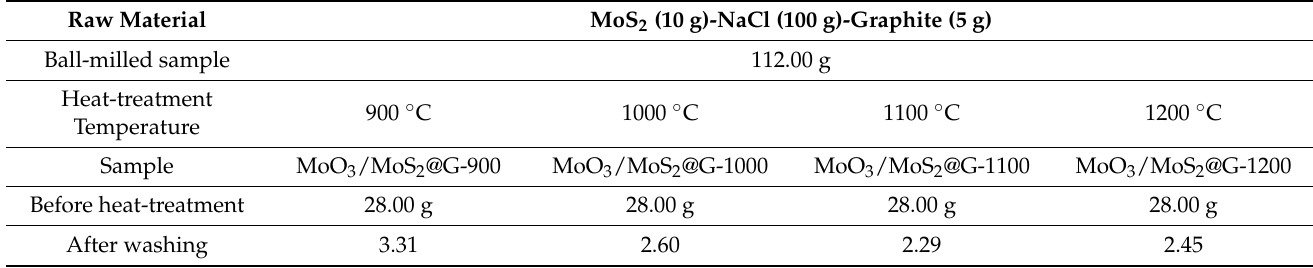
Table 6. Amounts of raw materials used and the resultant products obtained at various